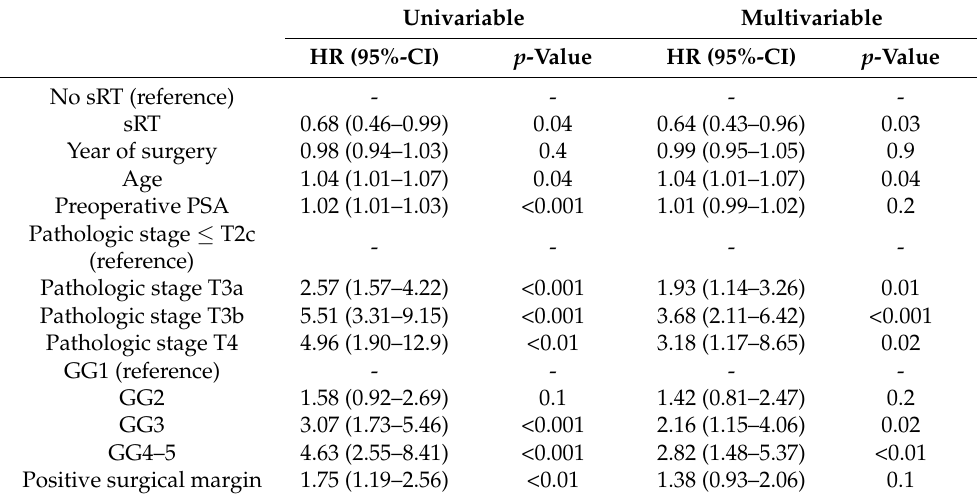
Table 3. Uni- and multivariable Cox regression predicting death of patients with biochemical recurrence after radical prostatectomy and 1:1 matching, stratified according to salvage radiotherapy vs.